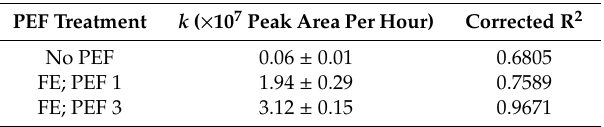
Table 2. Estimated kinetic parameters based on a zero-order kinetic model describing increases in DPDS, detected in the headspace of the sodium phosphate bu ff er (0.01 M, pH 7), over the course of 6 h of steeping with untreated and PEF-treated onion